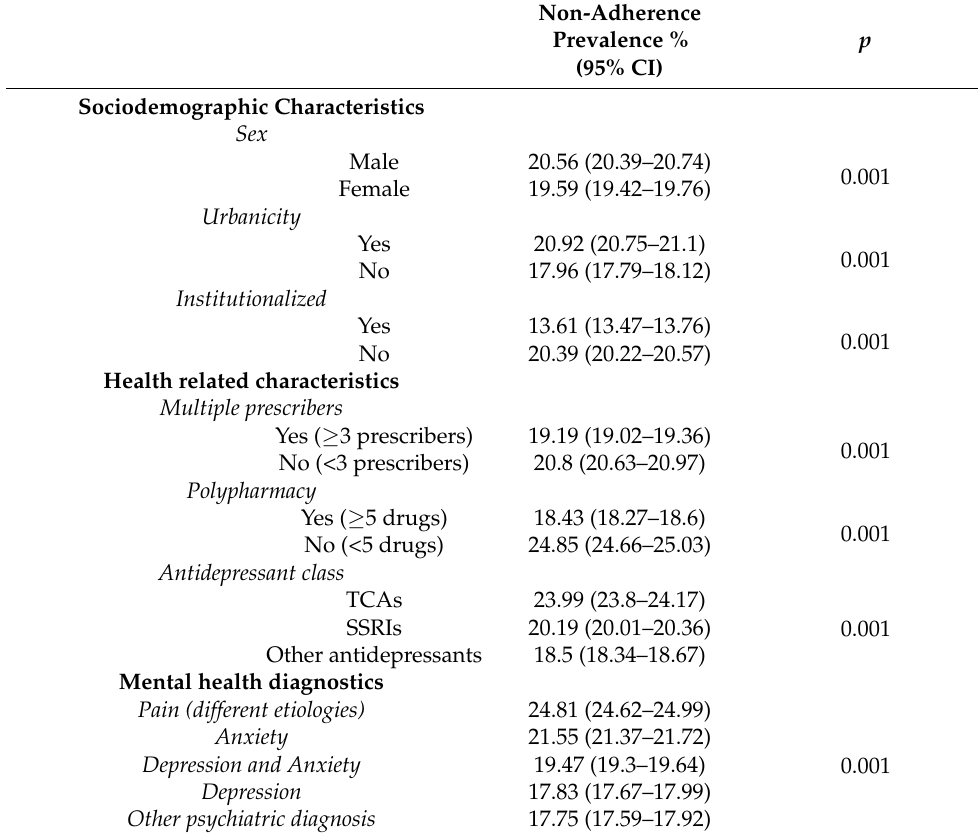
Non-Adherence p Prevalence % (95% CI)